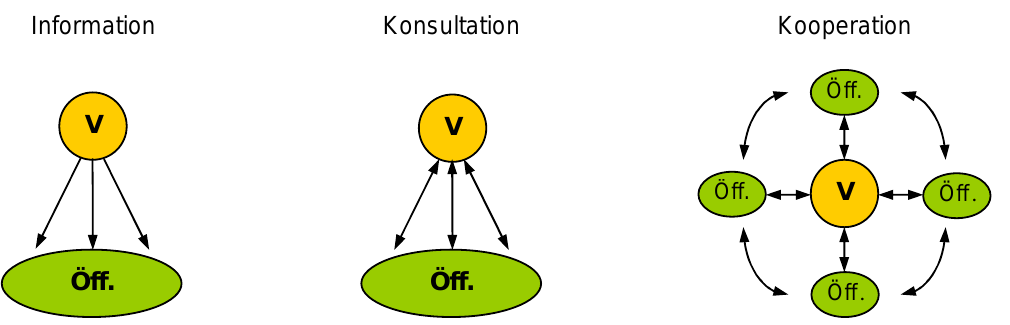
Figure 2: Kommunikationswege bei informativer, konsultativer und kooperativer Öffentlichkeitsbe- teiligung (V = Verwaltung, Öff. = Öffentlichkeit; verändert nach: Arbter, K., 2007a); Grafik: Arbter,